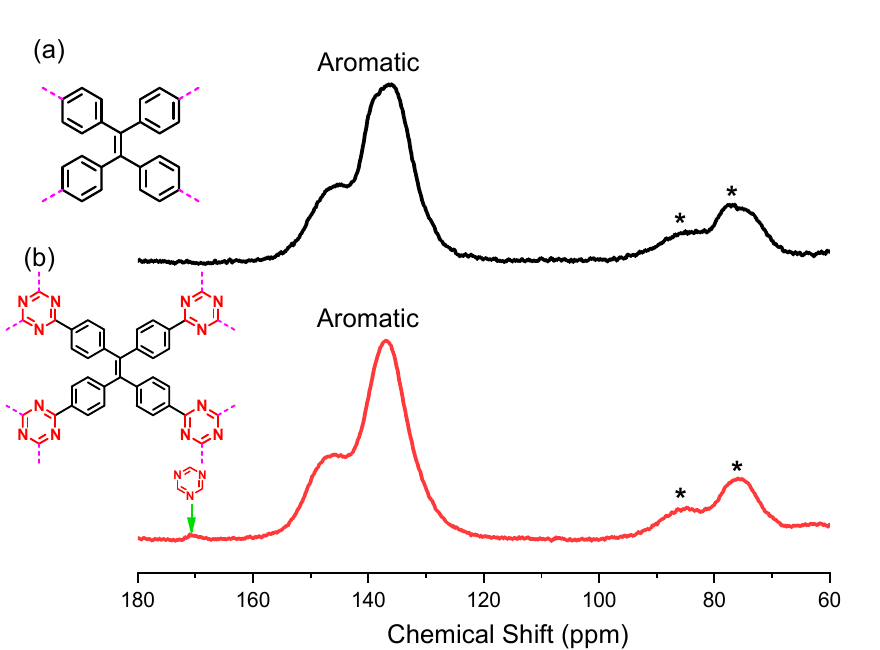
Figure 2. Solid state 13 CNMR spectra ( a ) TPE-CPOP1 and ( b ) TPE-CPOP2. where * is the side band of solid-state NMR.